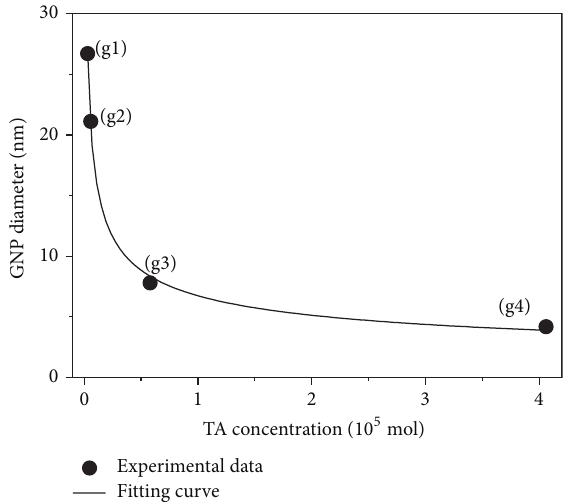
Figure 3: GNPs size as a function of added TA. The fitting curve corresponds to 𝑦 = 𝑎𝑥 𝑏 with 𝑎 = 0.074 and 𝑏 = −0.39187 . The narrow absorption band observed at 523 nm is the characteristic of almost spherical nanoparticles. For particles